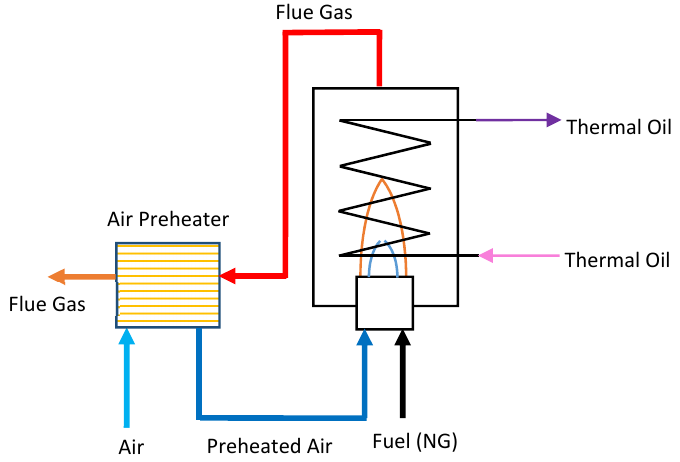
Figure 4. Thermal oil boiler with waste heat recovery system. Table 3. Impacts of Implementation of Waste Heat Recovery on B01.